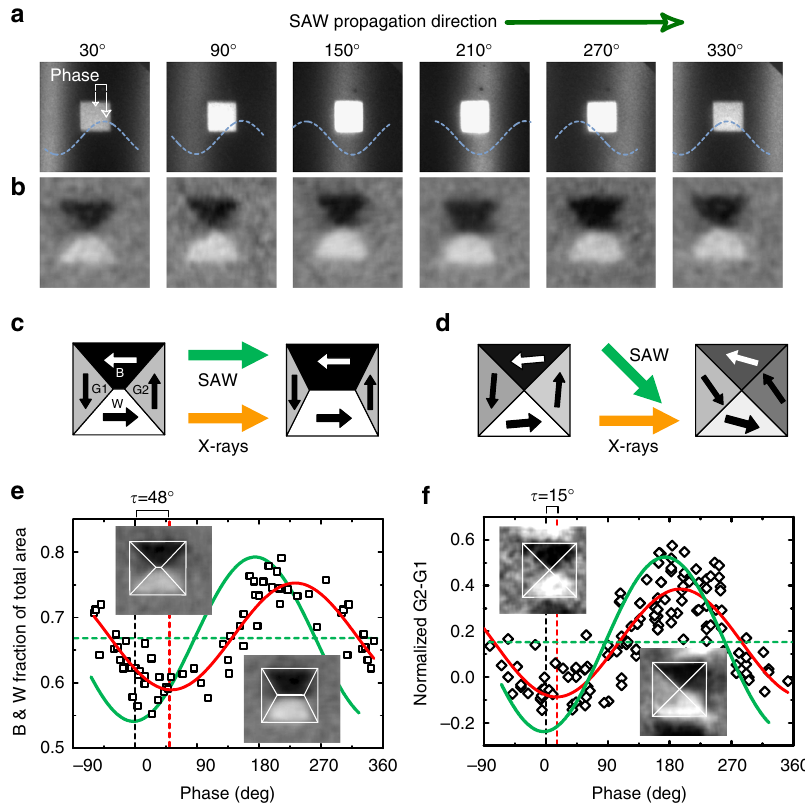
Fig. 3 Simultaneous images of SAW and magnetic domains. a PEEM and b XMCD – PEEM images of a 2 × 2 μ m 2 Ni square at different phases of the SAW. Images correspond to phase lapses of 60° (that correspond to 333 ps). PEEM images are 8 × 8 μ m 2 ; XMCD – PEEM images are 4 × 4 μ m 2 . c and d are schematic plots of the effect of SAW on Ni squares for con fi gurations where SAW were aligned with the squares ’ sides c and with the squares ’ diagonals d . e Analysis of the domain con fi guration from multiple (4) Ni squares of 2 × 2 μ m 2 as a function of the individual phase with respect to the SAW for the con fi guration shown in c . We computed the area of black and white domains (amount of magnetization along the X-ray incidence direction). f Analysis of the domain con fi guration from multiple (9) Ni squares of 2 × 2 μ m 2 as a function of the individual phase with respect to the SAW for the con fi guration shown in d . We computed the intensity difference of the relative normalized gray domains , ( I (G1) − I (G2))/( I (W) − I (B)). A best fi t to the data with a sinusoidal function is plotted in red in both b and c . Delays of τ = 48° ± 3 and τ = 15° ± 3 with respect to the strain wave were obtained, respectively, for the two con fi gurations. A schematic strain wave is plotted in green (with no scale) to indicate the phase values corresponding to maximum and minimum